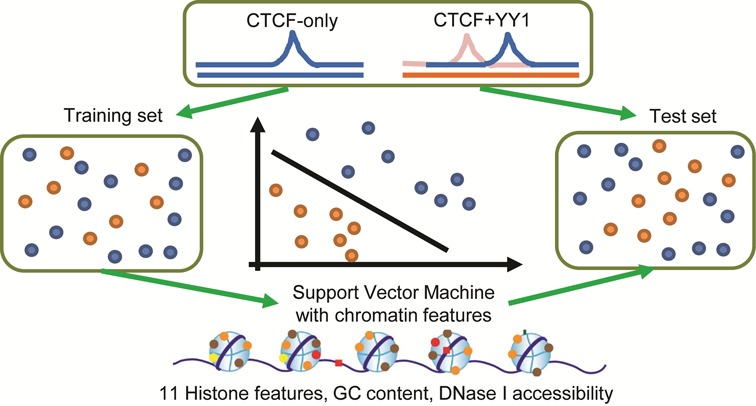
Schematic of the SVM approach used to predict TF–TF and TF-only, or TF–TF and TF-only binding events. YY1 was selected as a representation of CTCF binding partners for illustration. All binding events, including CTCF-TF co-occupying and CTCF-/TF-only binding regions, were separated into training and testing datasets. Then SVM classifier was trained using all or a subset of 11 HMs, DNase I and GC content. The trained model was applied to the test dataset for prediction accuracy valuation with ROC curves, AUC and ACC values. The model was also applied to the same TF–TF pair in different cell types for cross-cell type tests.